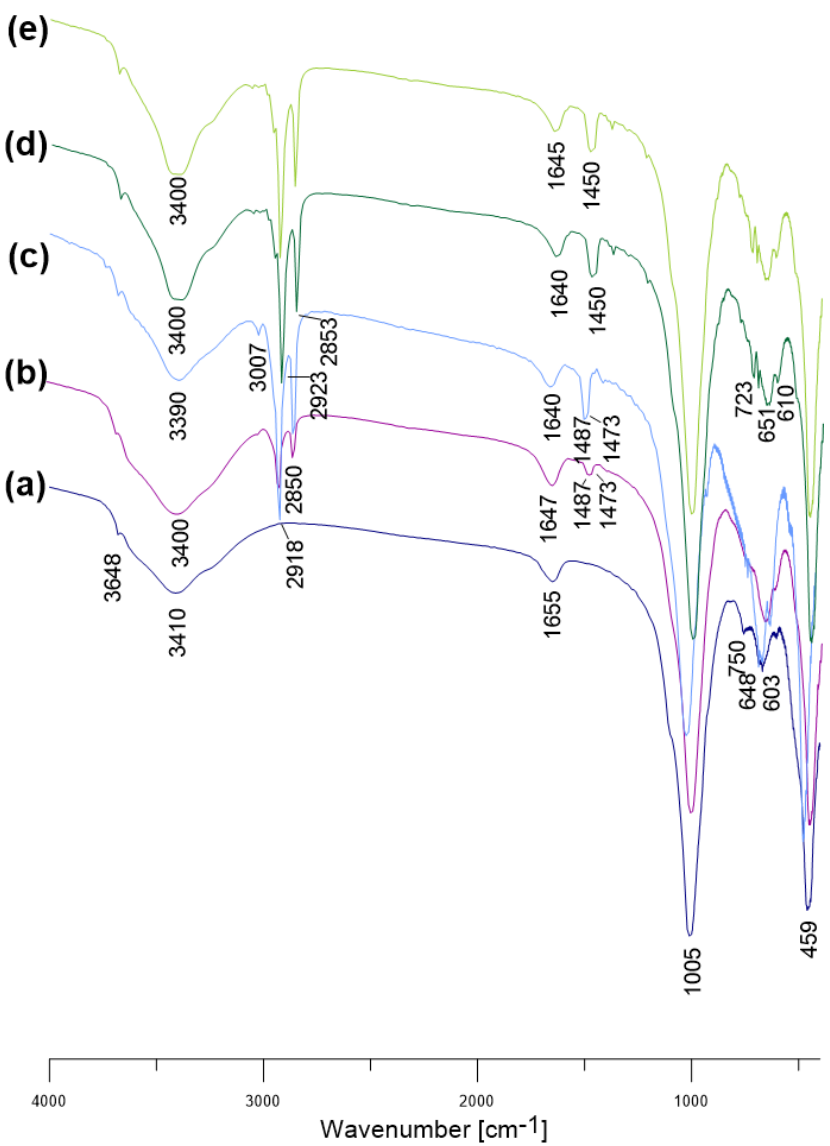
Figure 3. FTIR spectra of: ( a ) VER, ( b ) 0.5 HDTMA, ( c ) 2.0 HDTMA, ( d ) 0.5 HDBA, and ( e ) 2.0 HDBA.